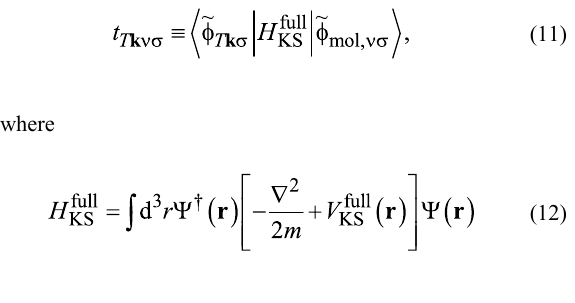
matrix elements. In principle, all these matrix elements can be absorbed into the model Hamiltonian H mol . In the substrate sector, the off-diagonal